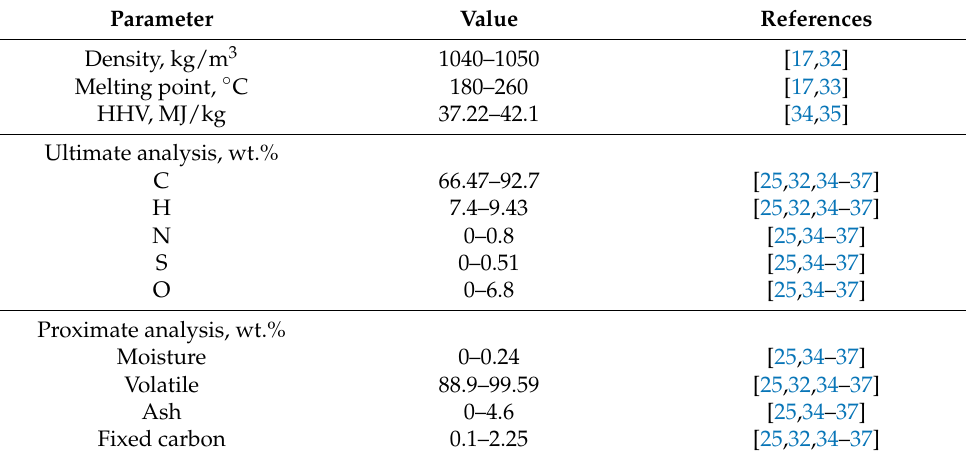
Table 1. Summary of physicochemical properties of PS raw